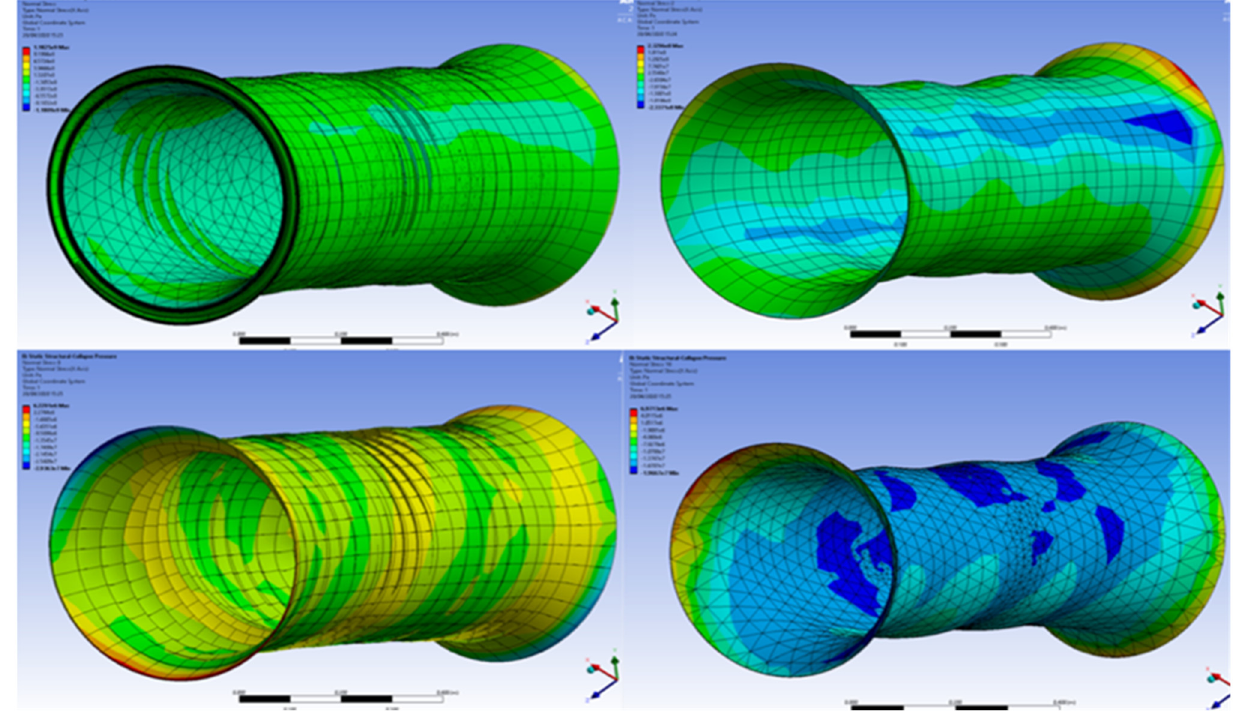
Figure 20. Collapse loading of different layers under extreme conditions, for normal stress on 4 different layers of the marine hose (under 0.5× magnification, and the ends are without end fitting or additional reinforced ends) .